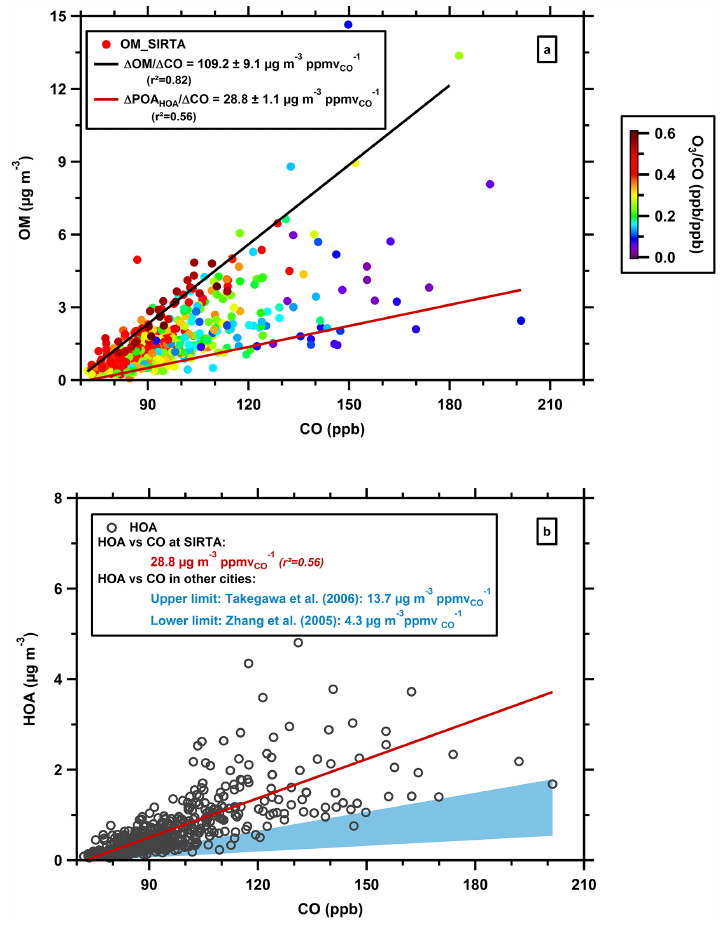
Figure 5. Scatterplots of OM versus CO (a) and scatterplots of HOA versus CO (b) in suburban Paris in summer 2009. OM, CO and HOA were averaged to